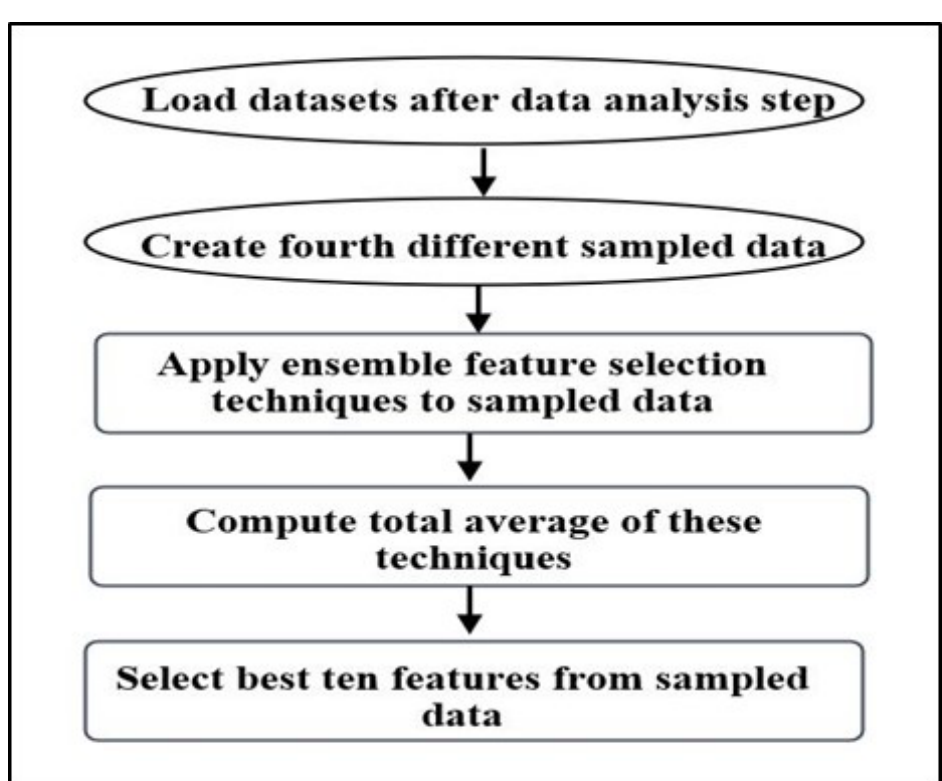
Figure 2. Framework of the fourth